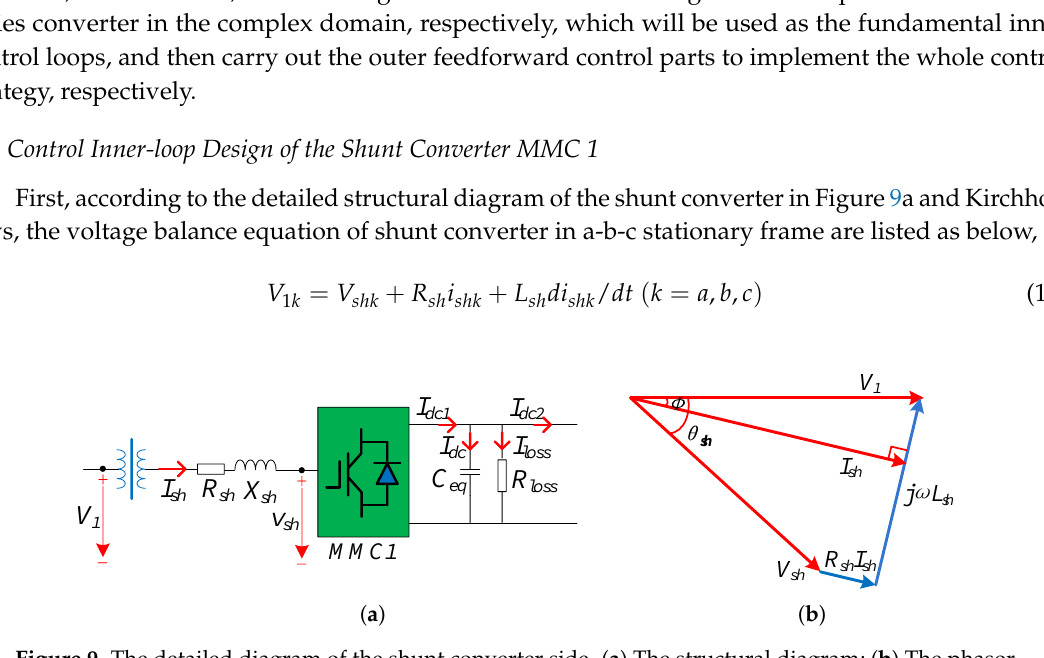
Figure 9. The detailed diagram of the shunt converter side. ( a ) The structural diagram; ( b ) The phasor diagram of the